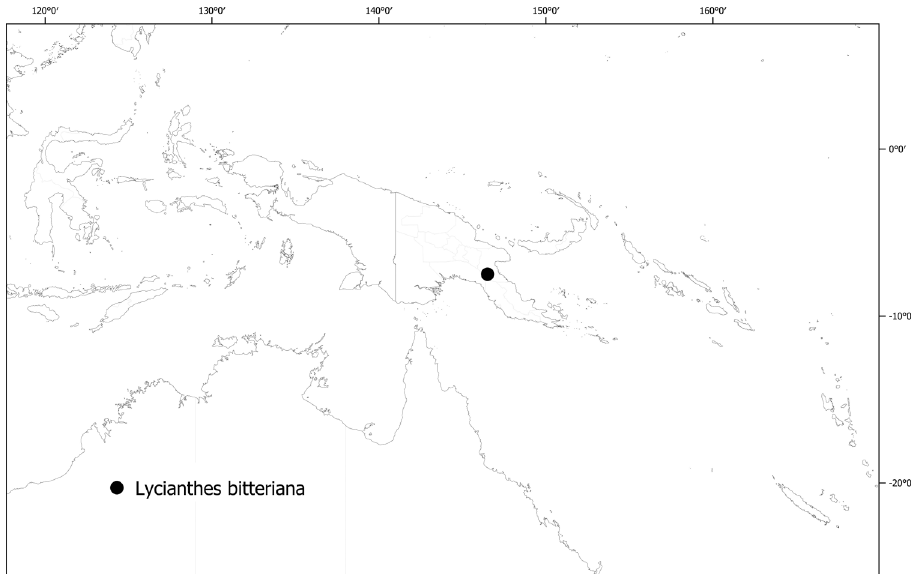
Figure 15. Distribution of Lycianthes bitteriana